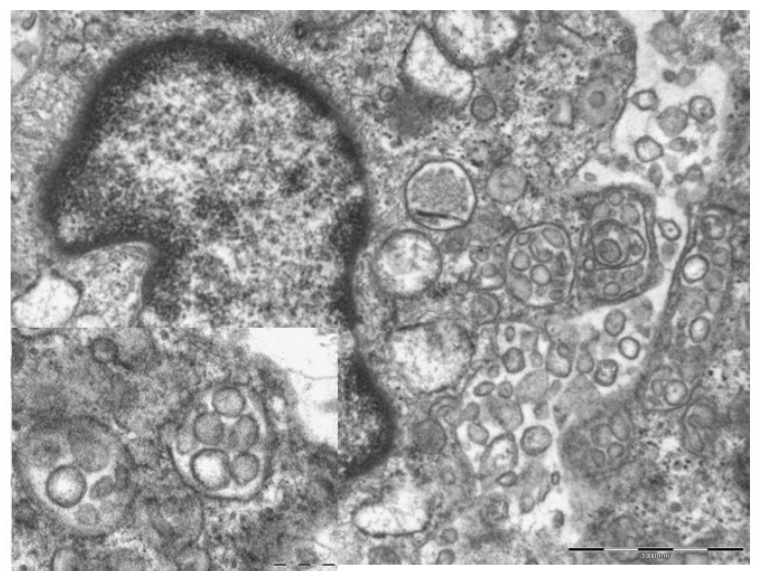
Figure 8. The photomicrograph shows the endothelial cell cytoplasm, with numerous vacuoles within which viral particles are observed (14,000 x and 71,000 box).